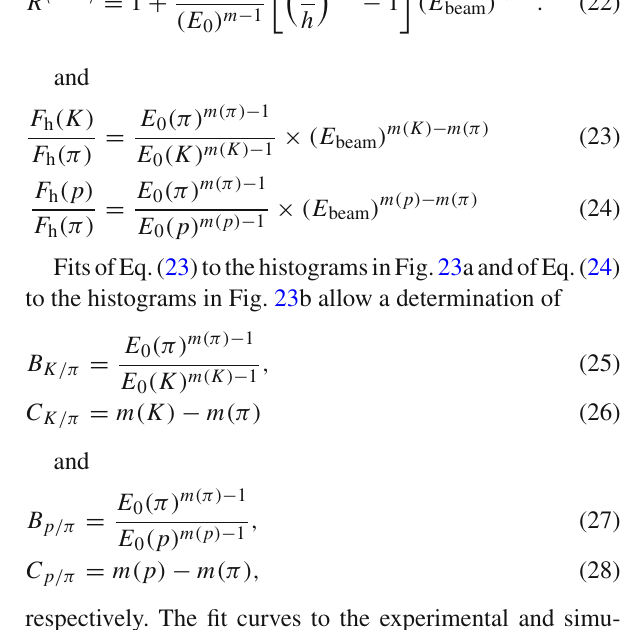
R (cid:6) E raw (cid:7) = 1